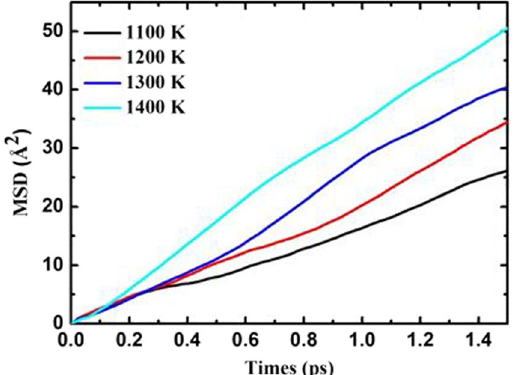
Figure 4. MSD for proton transfer in the cluster of (Li 2 CO 3 ) 8 simulated at 1100 K, 1200 K, 1300 K, and 1400 K for 3 ps.